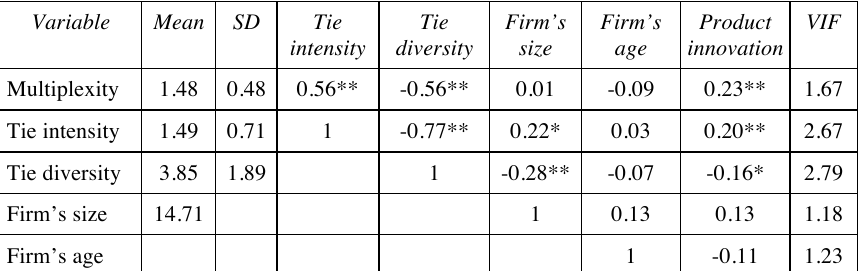
Table 3. Correlation between variables and some descriptive results of the main variables.